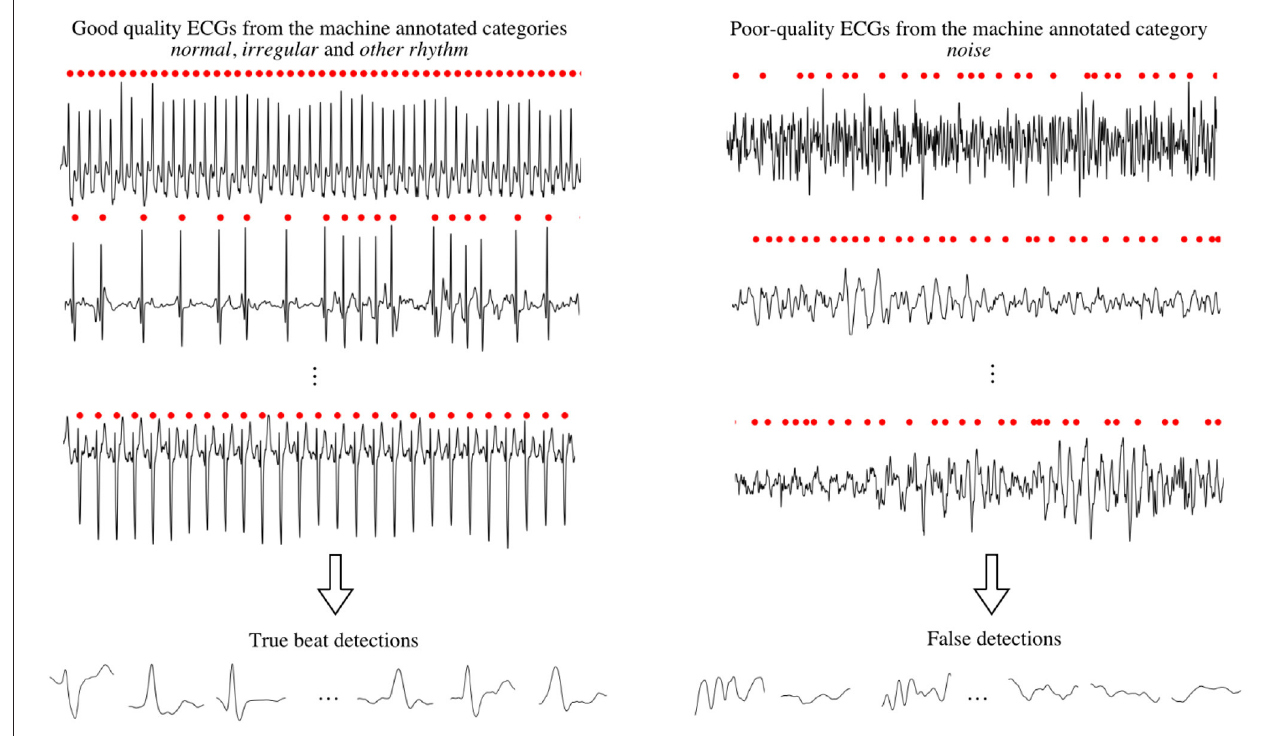
FIGURE 3 | Compiling the events, i.e., true beat detections and false detections, for CNN training, validation, and testing.